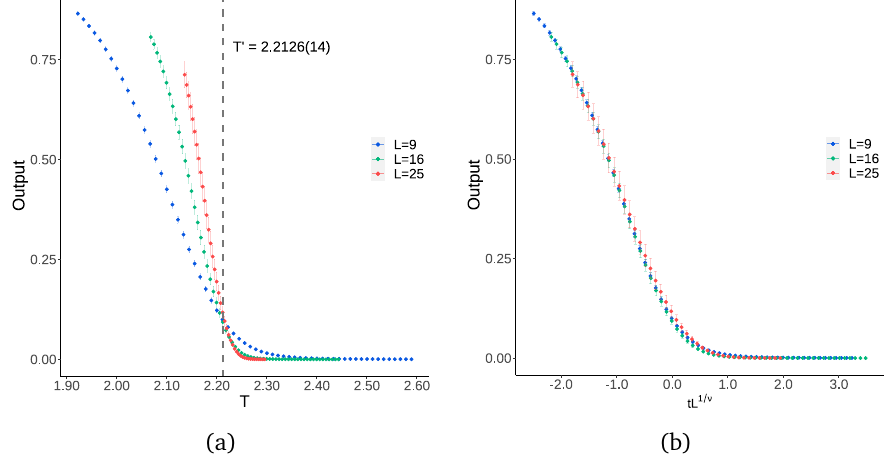
Figure 2: Generalization of two-dimensional Ising model-trained ANNs to the three-dimensional 2-state Potts model. a , Average outputs of two-dimensional Ising model-trained ANNs versus sampling temperature for spin configurations of the three-dimensional 2-state Potts model. b , The associated finite-size scaled results. The error bars shown are 99.7% confidence